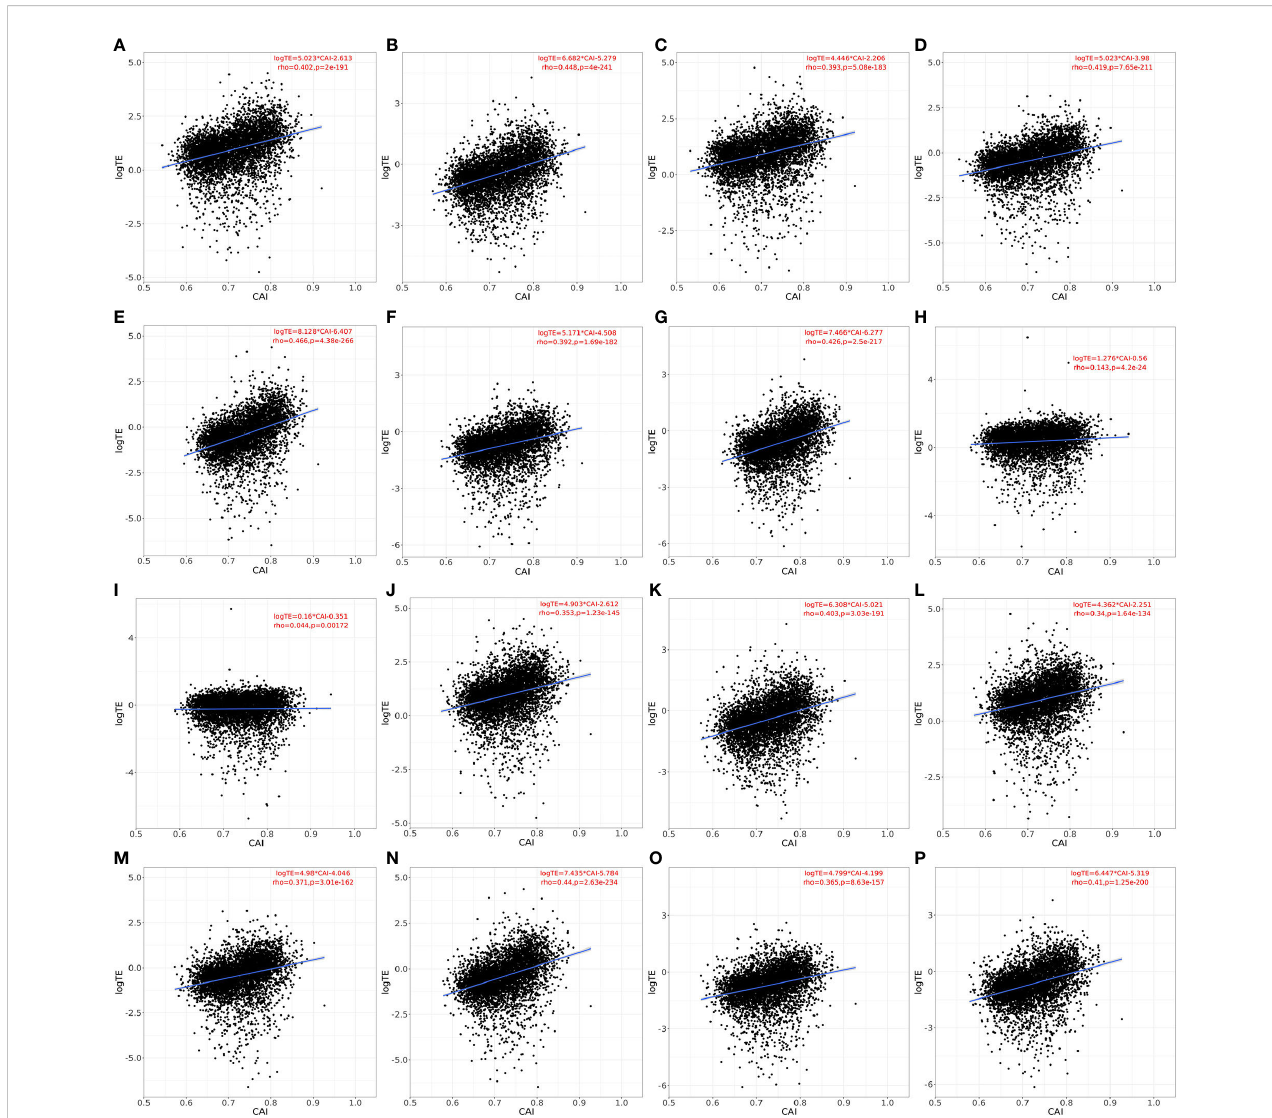
FIGURE 3 Linear relationship, spearman correlation coef fi cient and corresponding p-value between CAI and translational ef fi ciency for the top 5000 highly expressed genes (except genes which are not detected in Ribo-seq experiments) in each paired RNA-seq and Ribo-seq datasets. a-g. HBEC cells (cultured for 4 or 96h for A, B ; infected with SARS-CoV-2 for 4, 24, 48, 72, 96h for C-G ), normal CAI (cell-speci fi c highly expressed gene set as the background gene set); H, I . patient-derived primary CD4+ T cells (control for H ; infected with HIV-1 for I ), normal CAI (cell-speci fi c highly expressed gene set as the background gene set); J-P . HBEC cells (cultured for 4 or 96h for J, K ; infected with SARS-CoV-2 for 4, 24, 48, 72, 96h for L-P ), ‘ nonspeci fi c ’ CAI (constructed nonspeci fi c gene set as the background gene set).